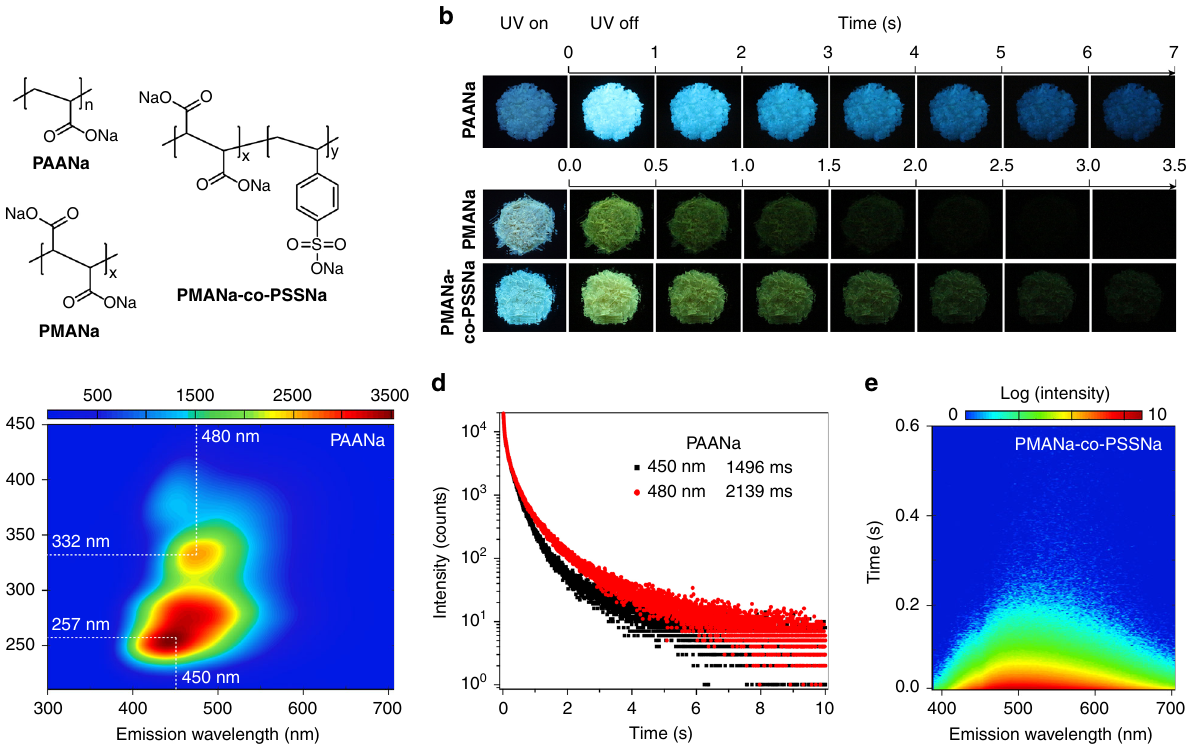
Fig. 5 Photophysical properties of PAANa, PMANa, and PMANa-co-PSSNa polymers in solid state under ambient conditions. a Molecular structures of PAANa, PMANa, and PMANa-co-PSSNa. b Photographs of PAANa, PMANa, and PMANa-co-PSSNa polymers taken before and after the irradiation of a 310 nm UV lamp. c Excitation-phosphorescence emission mapping of the PAANa polymer. d The lifetime pro fi les of the PAANa polymer monitoring at 450 and 480 nm. e Time-resolved emission spectra of the PMANa-co-PSSNa copolymer excited by 375